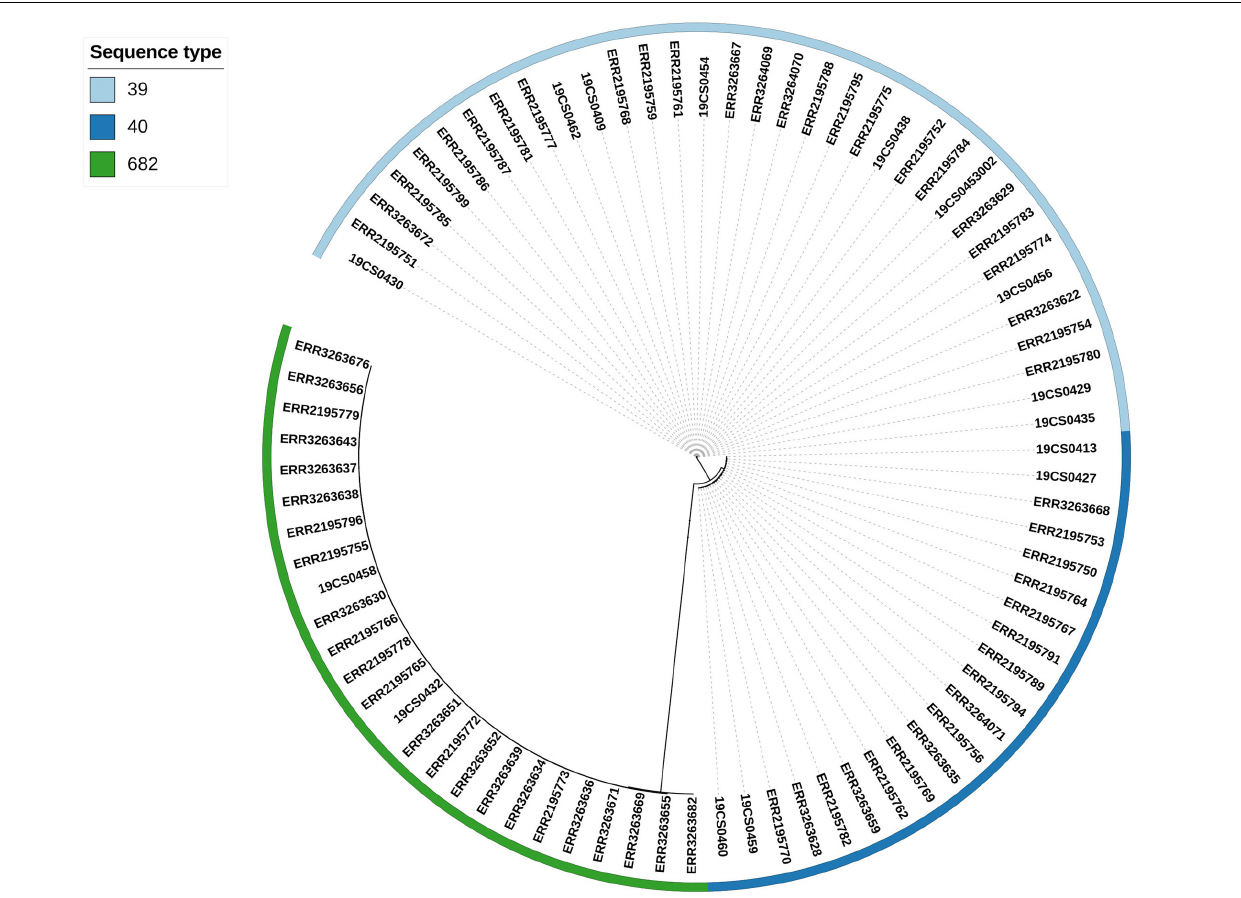
FIGURE 2 | Phylogenetic SNP tree of the 80 S. Derby strains. The colored zone alongside the tree represents the ST of the isolates: ST39 (bright blue), ST40 (dark blue), and ST682 (green).